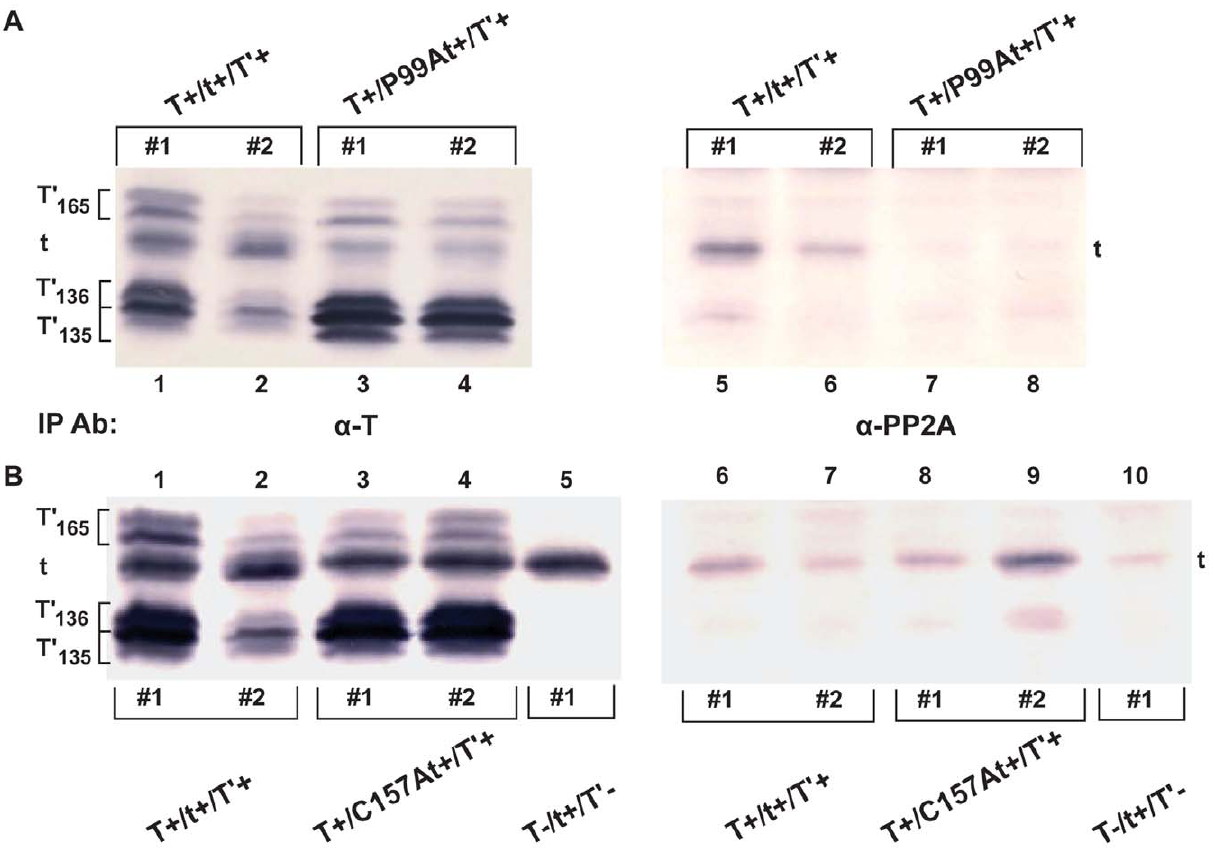
Figure 3. Interaction of mutant JCV tAgs with PP2A. Interactions between PP2A and wild-type tAg and (A) tAg-mutant P99A or (B) C157A were compared. 3T3 cells were stably transfected with DNA constructs expressing JCV early proteins under the control of SV40 promoter-enhancer signals. Lysates of these cells were subjected to IP with the anti-T monoclonal antibody PAb 962 ( a -T) or anti-PP2A antibody ( a -PP2A). The amount of total cell protein subjected to IP with anti-PP2A antibody (lanes 5–8, Panel A; lanes 6–10, Panel B) was five times that used with the anti-T antibody (lanes 1–4, Panel A; lanes 1–5, Panel B). Samples were electrophoresed on 18% SDS-polyacrylamide gels and transferred to nitrocellulose membranes. WB was performed using a cocktail of anti-T monoclonal antibodies. Results for two independently-derived cells lines ( # 1, # 2) containing DNA constructs that either encode all 5 JCV wild type early proteins (T + /t + /T 9 + ; Panel A, lanes 1,2,5,6, Panel B, lanes 1,2,6,7) or wild type TAg, T 9 165 , T 9 136 and T